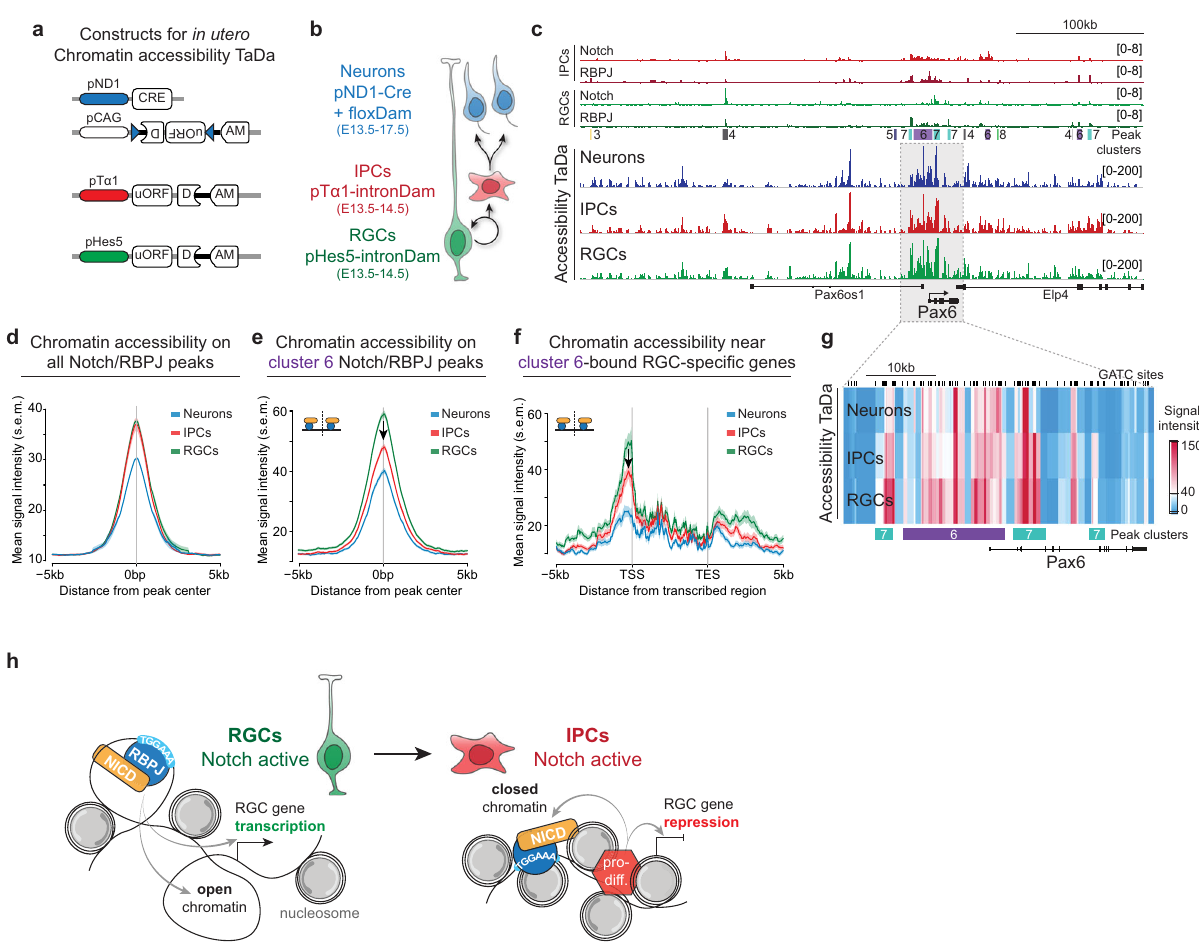
Fig. 5 Chromatin accessibility correlates with NOTCH target gene expression. a , b Constructs for in utero chromatin accessibility TaDa and cell type speci fi c expression pattern. c Chromatin accessibility pro fi les at the Pax6 locus (bottom), and the corresponding NOTCH/RBPJ binding pro fi les (top). d – f Accessibility (average signal ± s.e.m., shaded area) at all NOTCH/RBPJ peak regions d on NOTCH/RBPJ cluster 6 peaks e and on cluster 6-bound RGC- speci fi c genes f in the indicated cell types. g Heatmap of accessibility in the region highlighted in ( c ) colour scale indicates TaDa binding intensity. GATC sites and NOTCH/RBPJ peaks are indicated. h Model of NOTCH target gene repression during differentiation after ectopic expression of